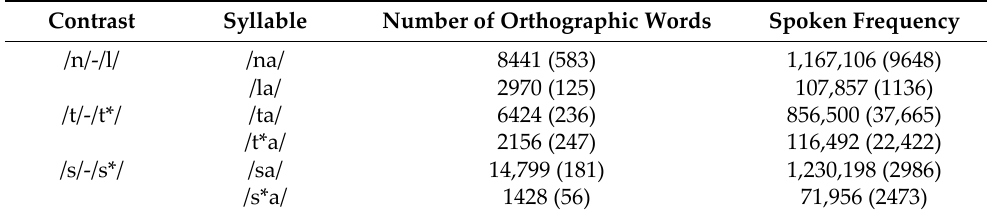
Table 3. Data from the SUBTLEX‑KR corpus on orthographic words with the same first syllable as the stimulus items in Ahn et al. (2017). Data on orthographic words with a similar first syllable that includes a coda /k/ are included in